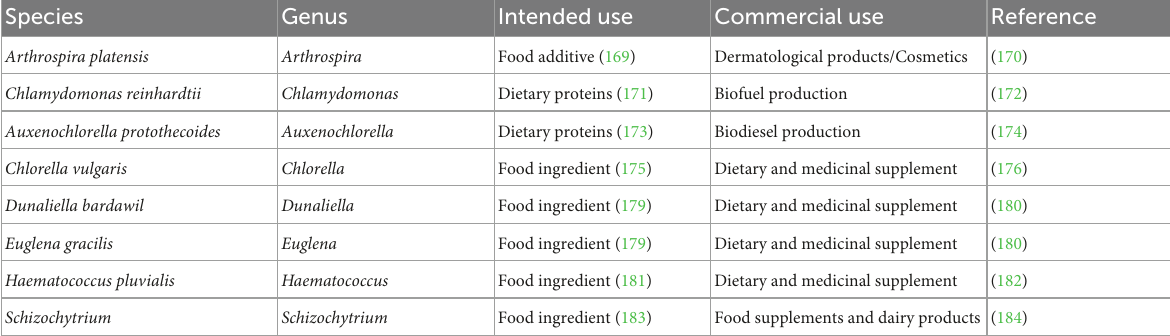
TABLE 3 Intended vs. commercial uses of GRAS status algae. Species Genus Intended use